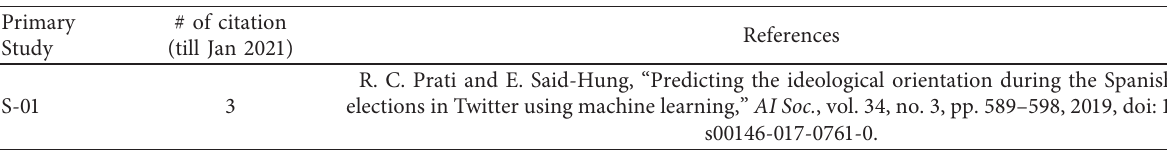
Figure 3: Search and selection flow. Table 5: Selected